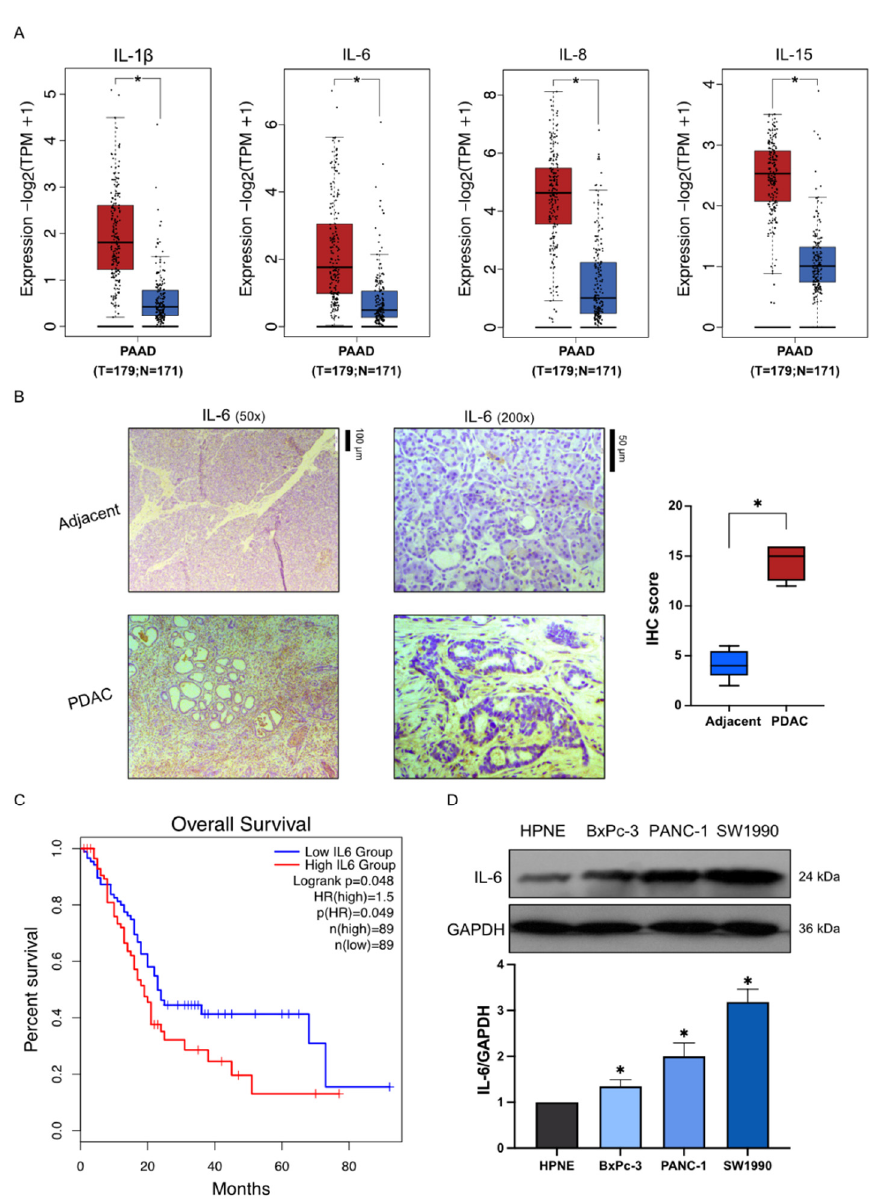
Figure 1. High-expression of inflammatory factors in pancreatic cancer. ( A ) The expression of IL-1 β , IL-6, IL-8, and IL-15 in samples from pancreatic cancer patients ( n = 179) and matching normal tissues ( n = 171). ( B ) Immunohistochemical analysis of IL-6 expression in pancreatic cancer tissue and tumor-adjacent tissue. ( C ) The overall survival (OS) curves comparing patients with high and low IL-6 expression in PAAD. ( D ) Western Blot analysis of IL-6 expression in HPNE, BxPC-3, PANC-1, and SW1990. Each bar represents mean ± SEM of three independent experiments. n = 3, * p < 0.05, compared with the matching control.